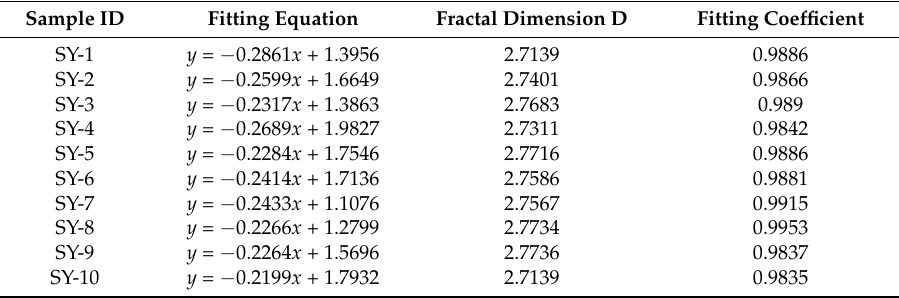
Table 4. Fractal dimensions of pores obtained from N 2 physisorption of the shale